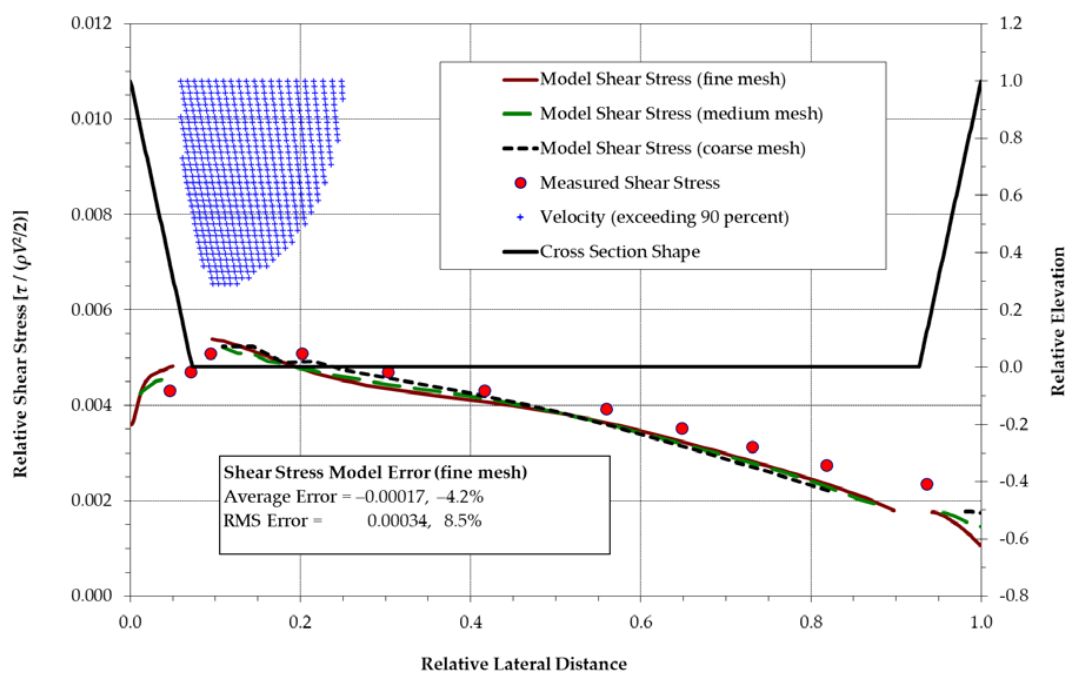
Figure 17. Comparison of simulated and measured shear stress for cross-section π / 8 (22.5 ◦ through the second channel curve). The channel cross section is also plotted along with the location of greatest velocity (within 90% of maximum velocity).